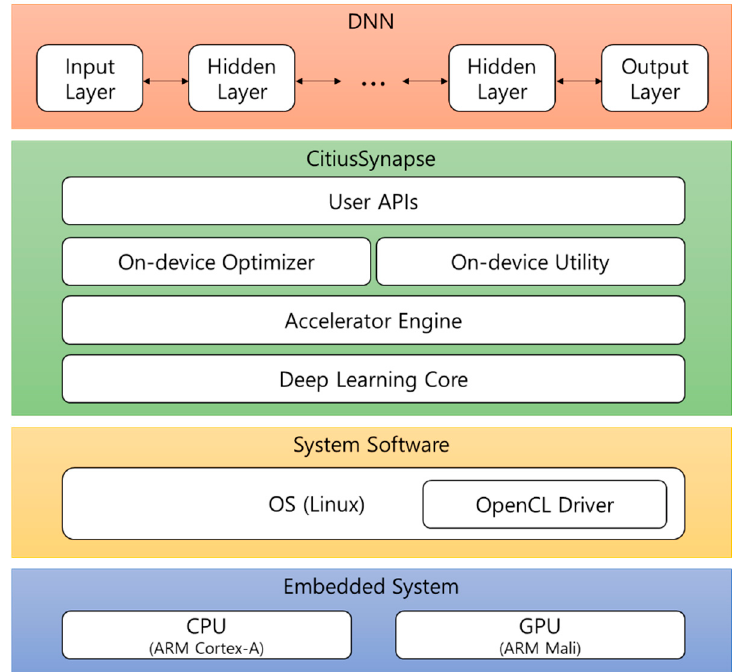
Figure 1. Overall architecture of our framework.